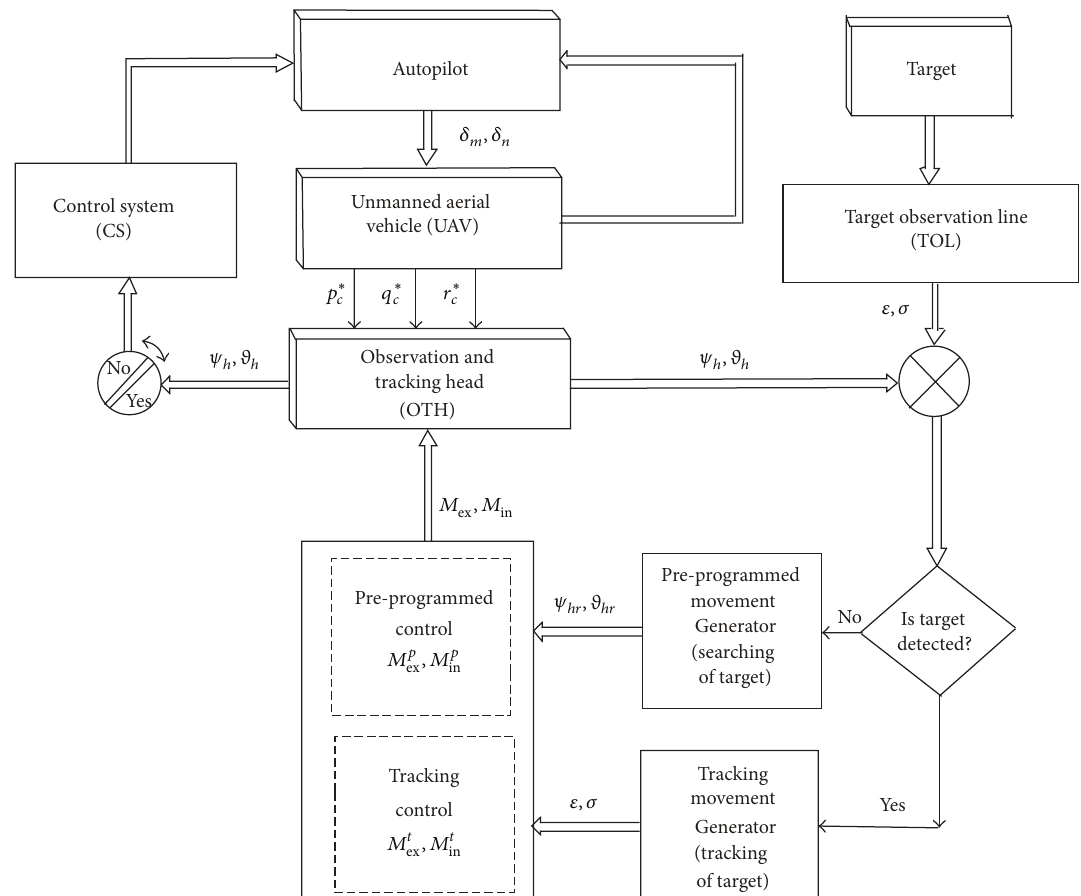
Figure 2: Diagram of operation of OTH mounted on UAV